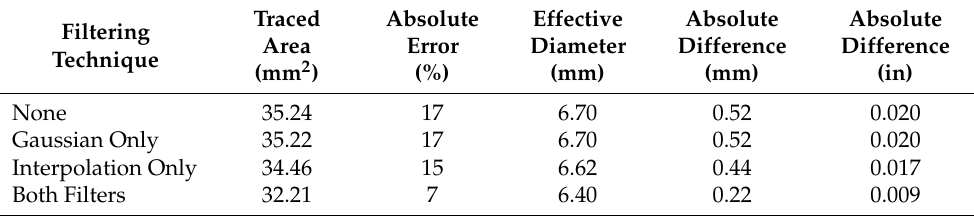
Table 2. Impact of filters on sizing of sample B2 using traditional 6 dB drop method.